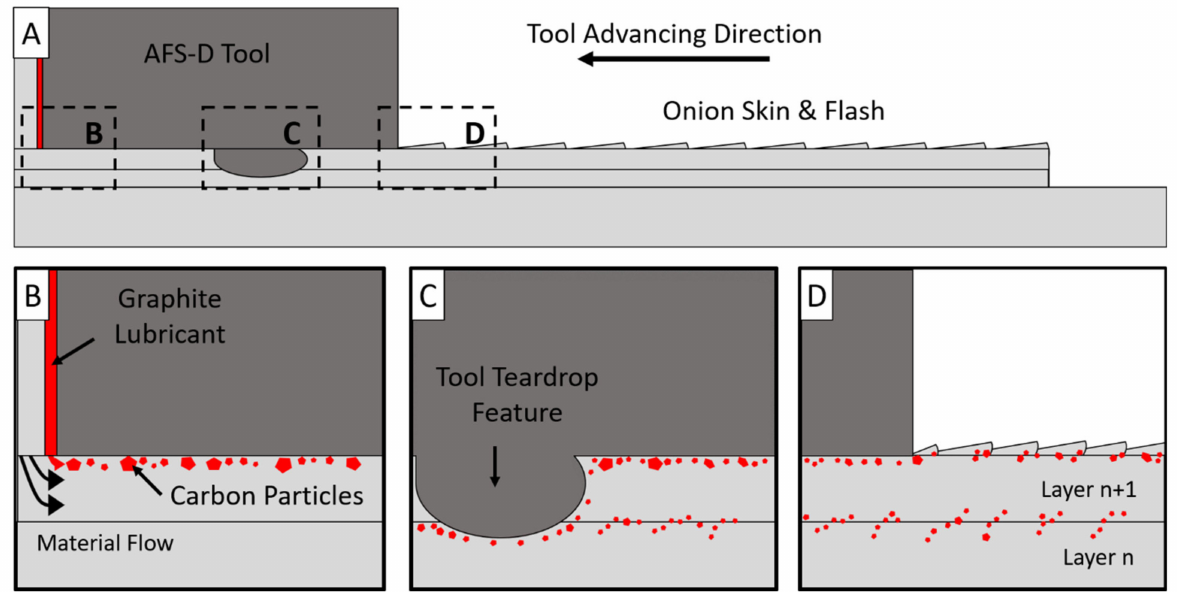
Figure 11. ( A ). Overview schematic of the cross section of the AFS-D tool, feedstock, and two layers. ( B ) Schematic of the material flow close to the tool exit hole. Carbon highlighted in red. ( C ) Schematic of the area near a tool teardrop feature. Carbon follows the path of the tool features rather than dissolving into the layers. ( D ) Carbon on the active layer becoming entrapped by the flash from excess material in the onion